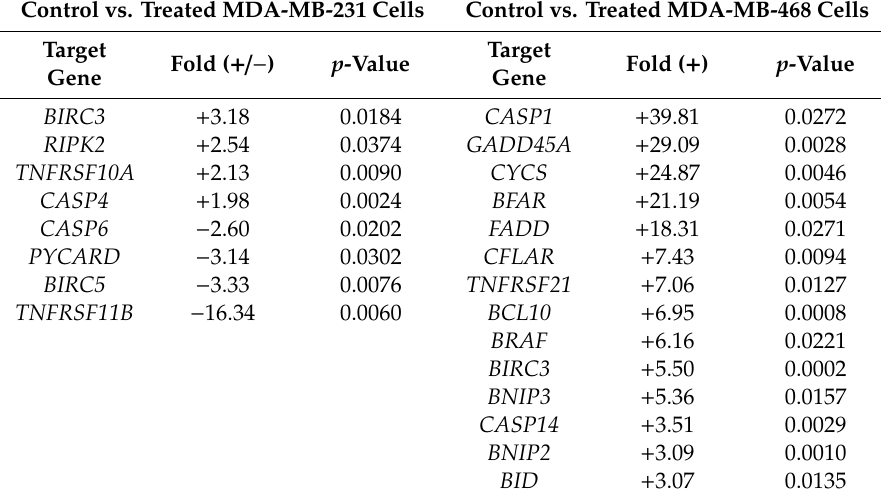
Table 1. A comparative illustration of oleuropein (OL) impacts mRNA gene expression in MDA-MB-231 and MDA-MB-468 TNBC cells after 48 h exposure